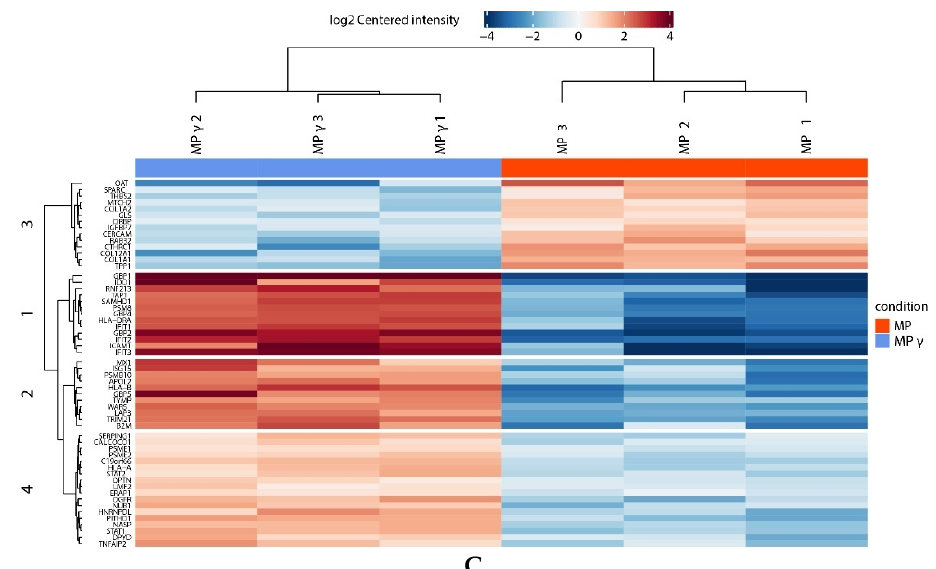
Figure 4. Effect of IFN γ treatment of MSC on EV and MP proteome. ( A ): Principle component analysis of EV, EV γ , MP and MP γ from three MSC donors on normalized abundance. The plot illustrates discrete categorization of biological replicates with relatively little donor variation in EV and larger donor variation in MP in PC1. ( B ): Heatmap with all significant enriched proteins in all EV samples ( p -value ≤ 0.05). Hierarchical clustering using average linkage shows that IFN γ has a strong effect on the protein composition of EV. ( C ): Heatmap with all significant enriched proteins in all MP samples ( p -value ≤ 0.05, log2 fold-change > 1.5). Hierarchical clustering using average linkage shows that IFN γ has a strong effect on the protein composition of MP.